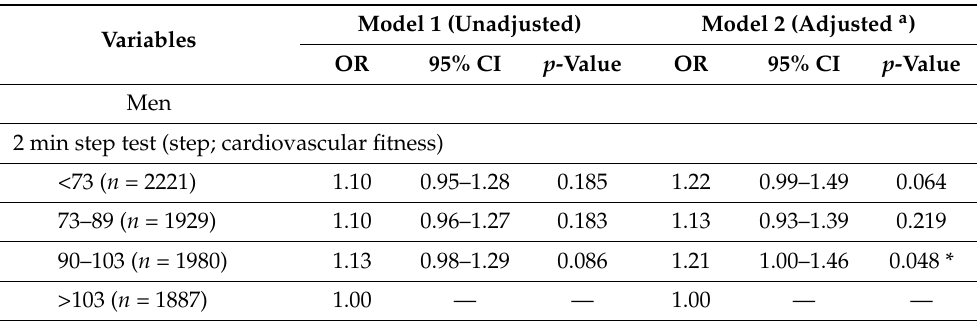
Table 3. Multivariate-adjusted odds ratios (ORs) for abdominal obesity in relation to quartiles of health-related physical fitness measurements after adjustment for potential